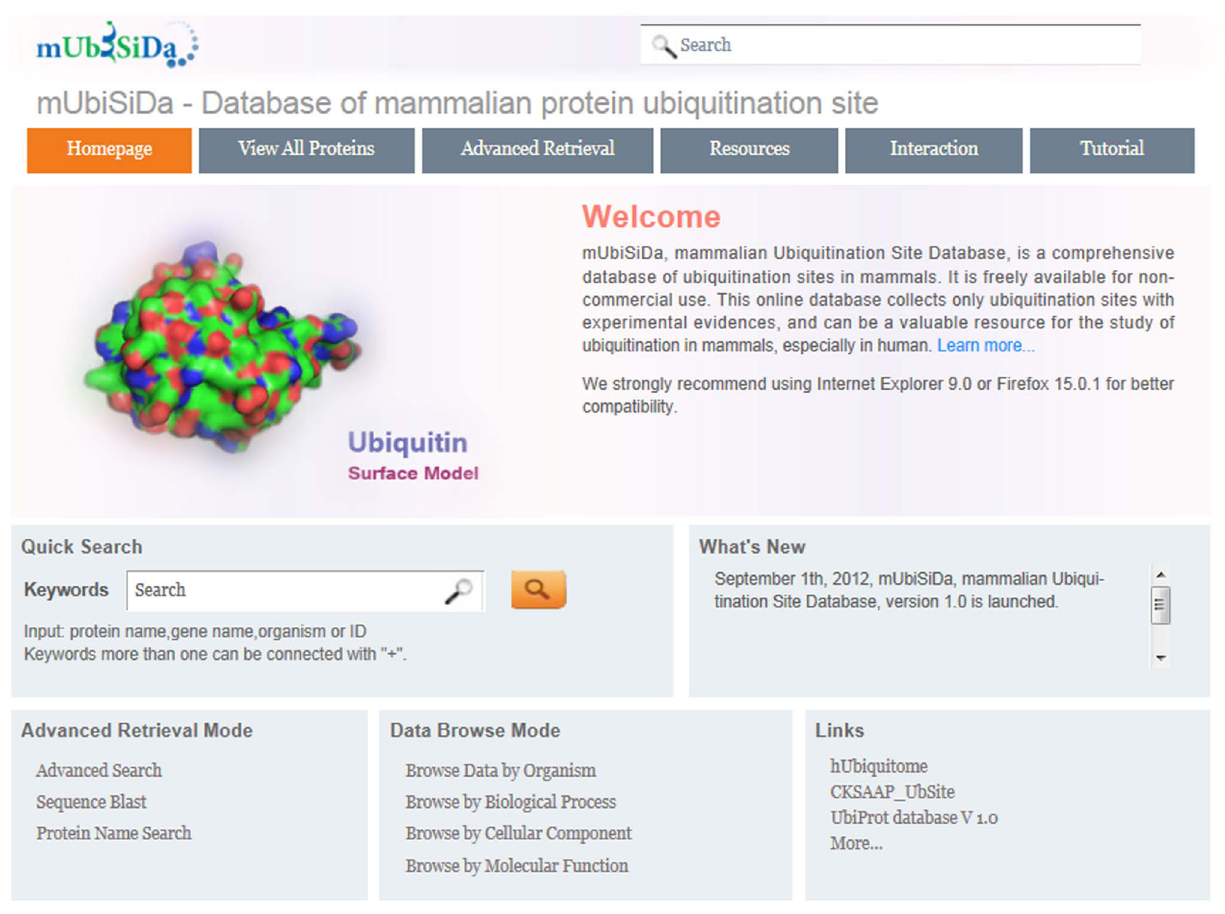
Figure 3. Home page of mUbiSiDa.